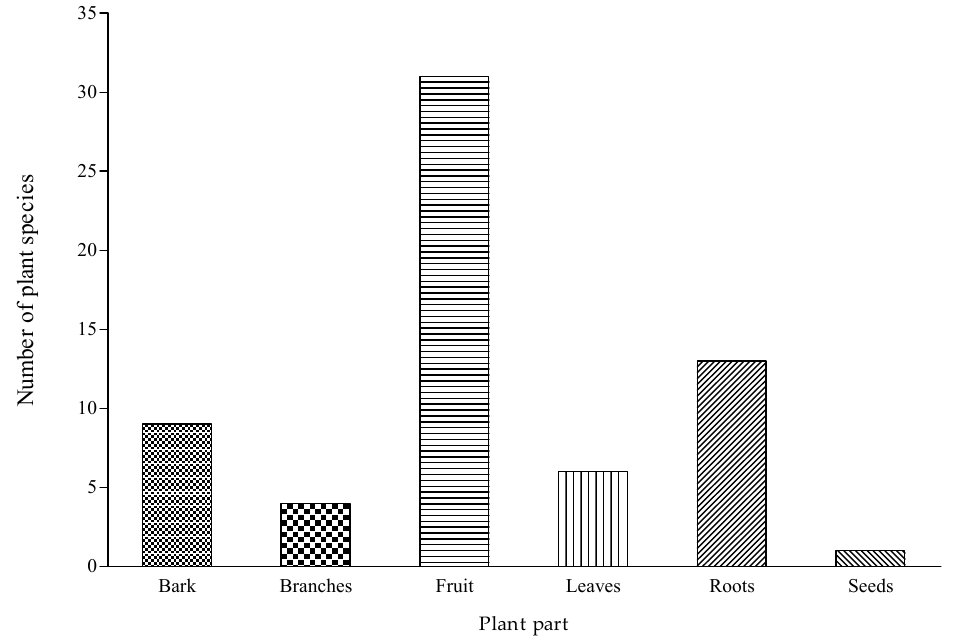
Figure 3. Plant parts of fruit trees used for different purposes in the three villages of Bushbuckridge Local Municipality, Mpumalanga province, South Africa.